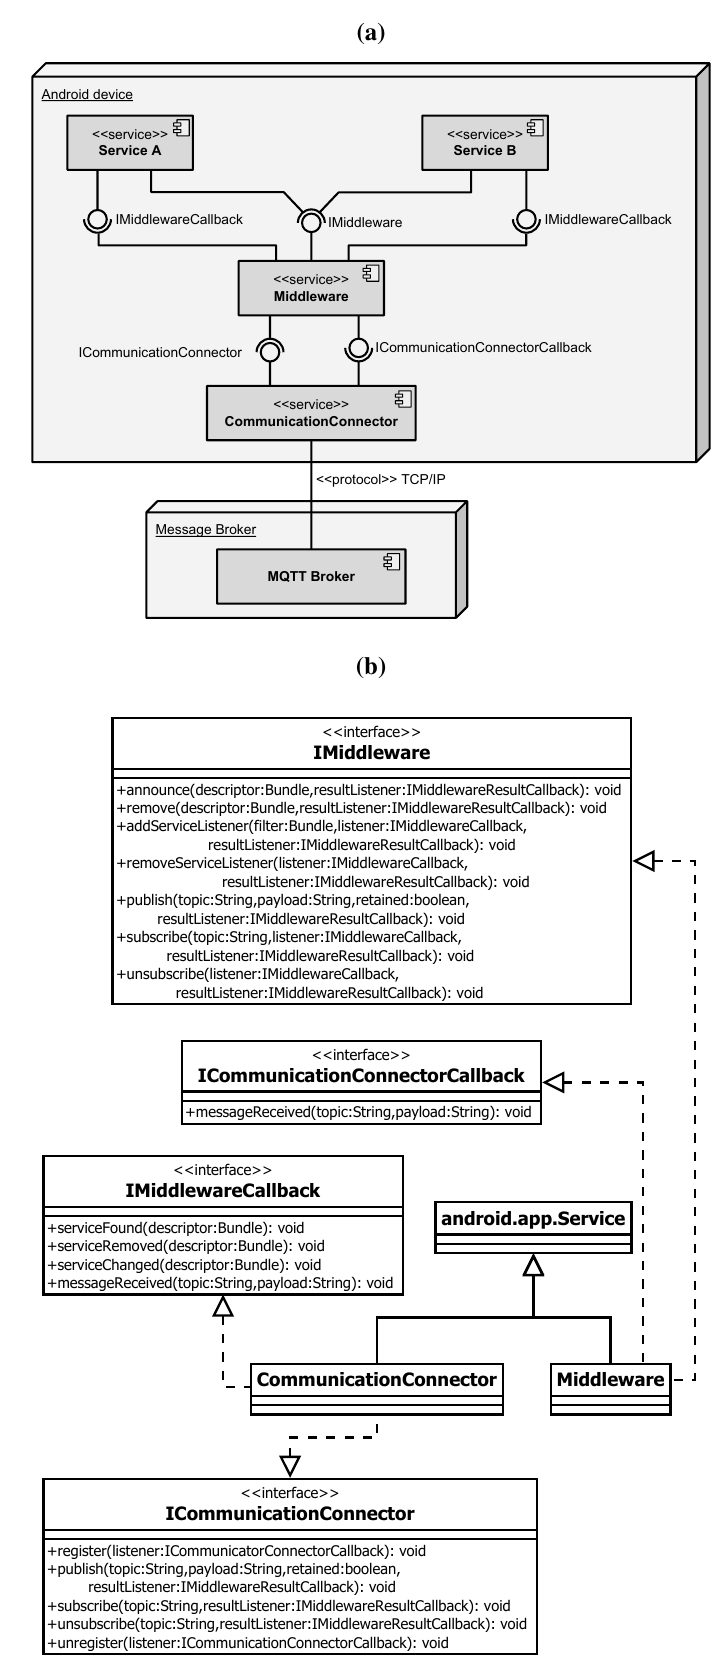
Figure 6. The Android middleware architecture with component ( a ) and class ( b )